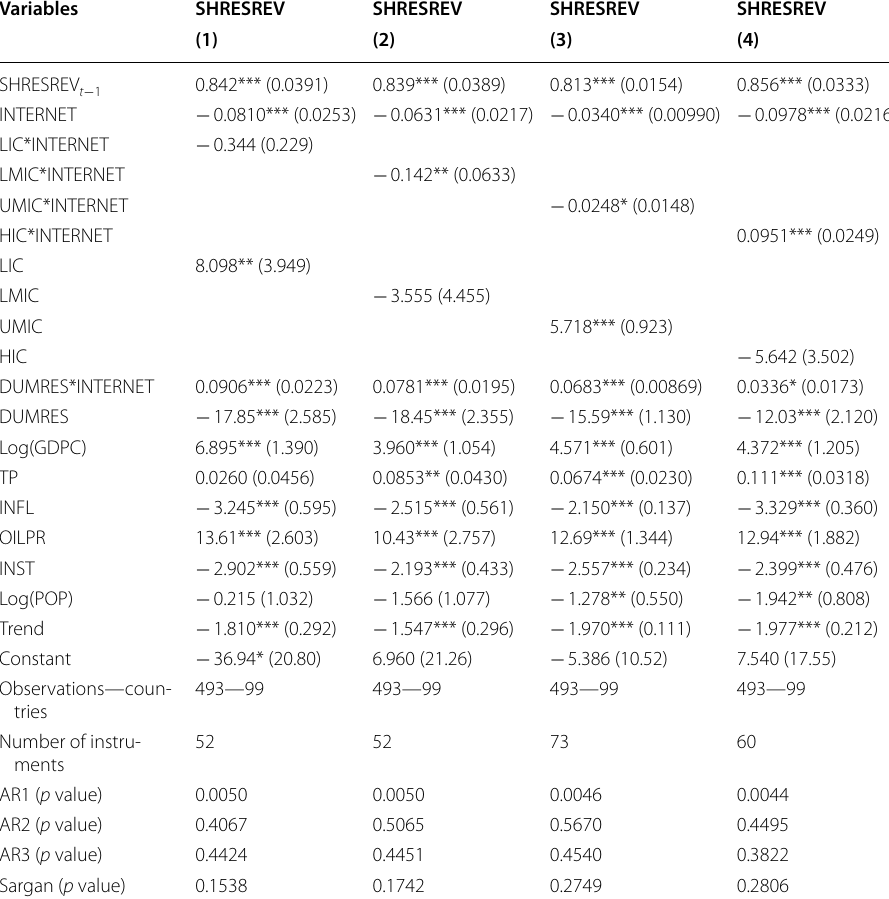
Table 4 Differentiated impact of the Internet usage intensity on the share (%) of resource revenue in total resource revenue across various sub-samples. Estimator : Two-Step System